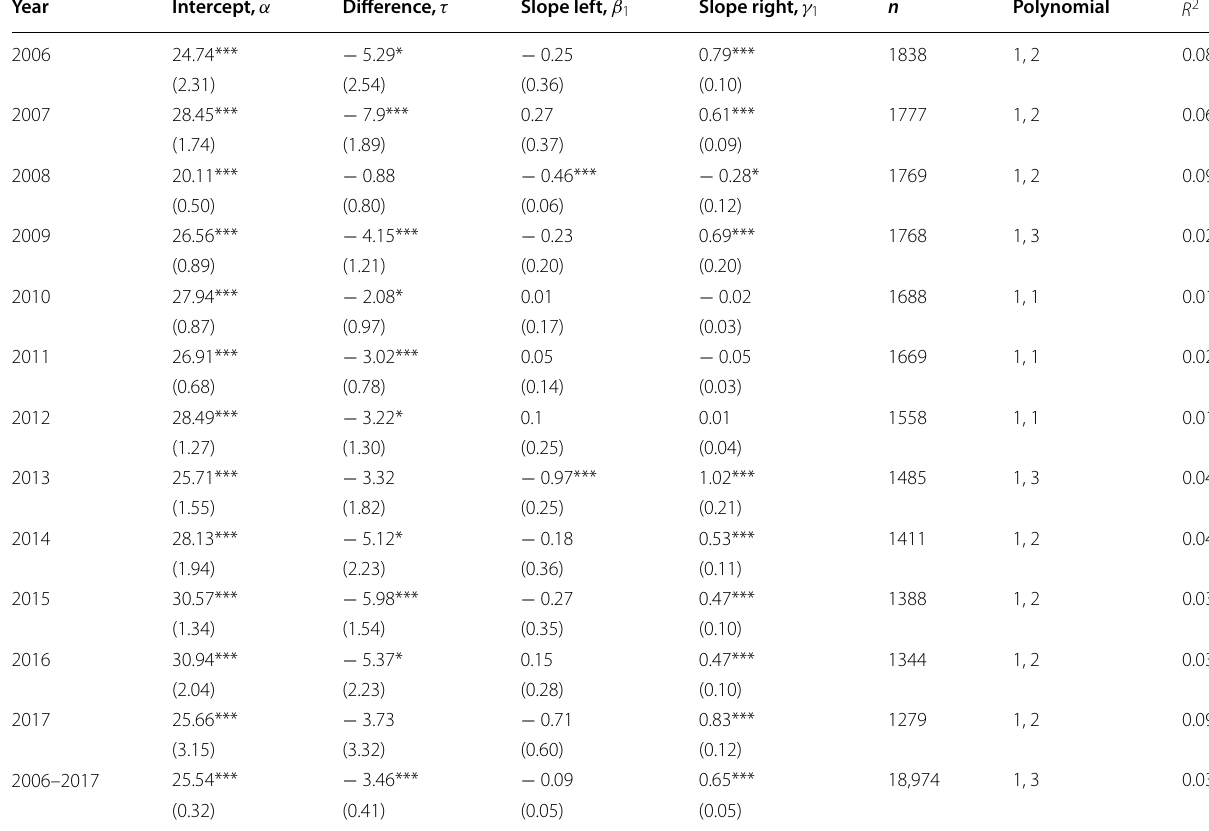
Coefficients for global polynomial regression for share of total assets invested in equities (in %), depending on funding ratio (in %) and polynomial terms. Table columns only show the estimates for the intercept ( α ), for the difference left and right of the cut-off ( τ ), and slopes (first polynomial terms, β 1 , and γ 1 ). Estimates from global polynomial regressions with separate polynomials to the left and right of a funding ratio of 100%. Selected number of polynomials based on the BIC selection criterion. Bootstrapped standard errors in parentheses (500 iterations). The last three columns show the number of observations (n), the number of selected polynomial terms (left, p , and right, q ), and the R 2 . Significance levels at 0.05 ∗ , 0.01 ∗∗ and 0.001 ∗∗∗ . Estimates for τ show a negative and significant difference between unfunded and funded funds in almost all years (excluding 2008, 2013, 2017). In the pooled regression (last row), the difference is 3.46 percentage points. For sufficiently funded funds, the share of equity assets is positively related to the funding ratio ( γ 1 > 0 ) in almost all years (excl. 2010–2012). The samples include only private and public funds without state guarantees, and includes only funds with a funding ratio between 81.5 and 152.3% (0.5th–95th percentile